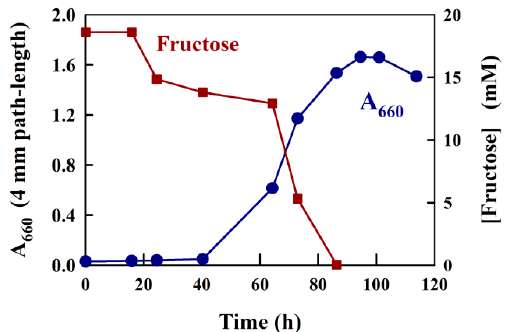
Figure 4. Growth curve data and fructose measurement for R. rubrum growing semi-aerobically on fructose/succinate M2SF medium in a shake flask at 30 °C (dark conditions). The cell turbidity (A 660 ) was measured at 660 nm, which contained no contribution from photosynthetic pigments.